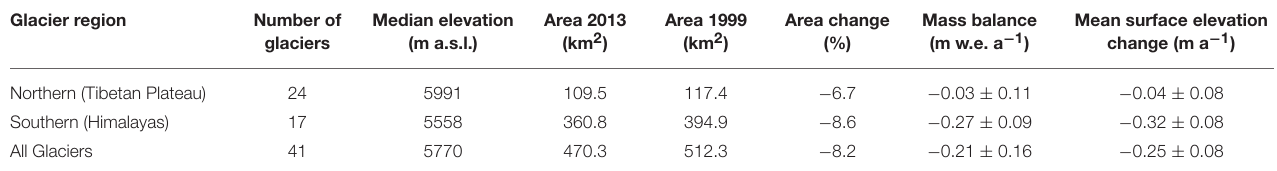
TABLE 3 | Mean glacier changes for the glaciers on the Tibetan Plateau (Northern glaciers) and those south of the topographic divide in the Himalayas (Southern glaciers) between 1999/2000 and 2013. Glacier